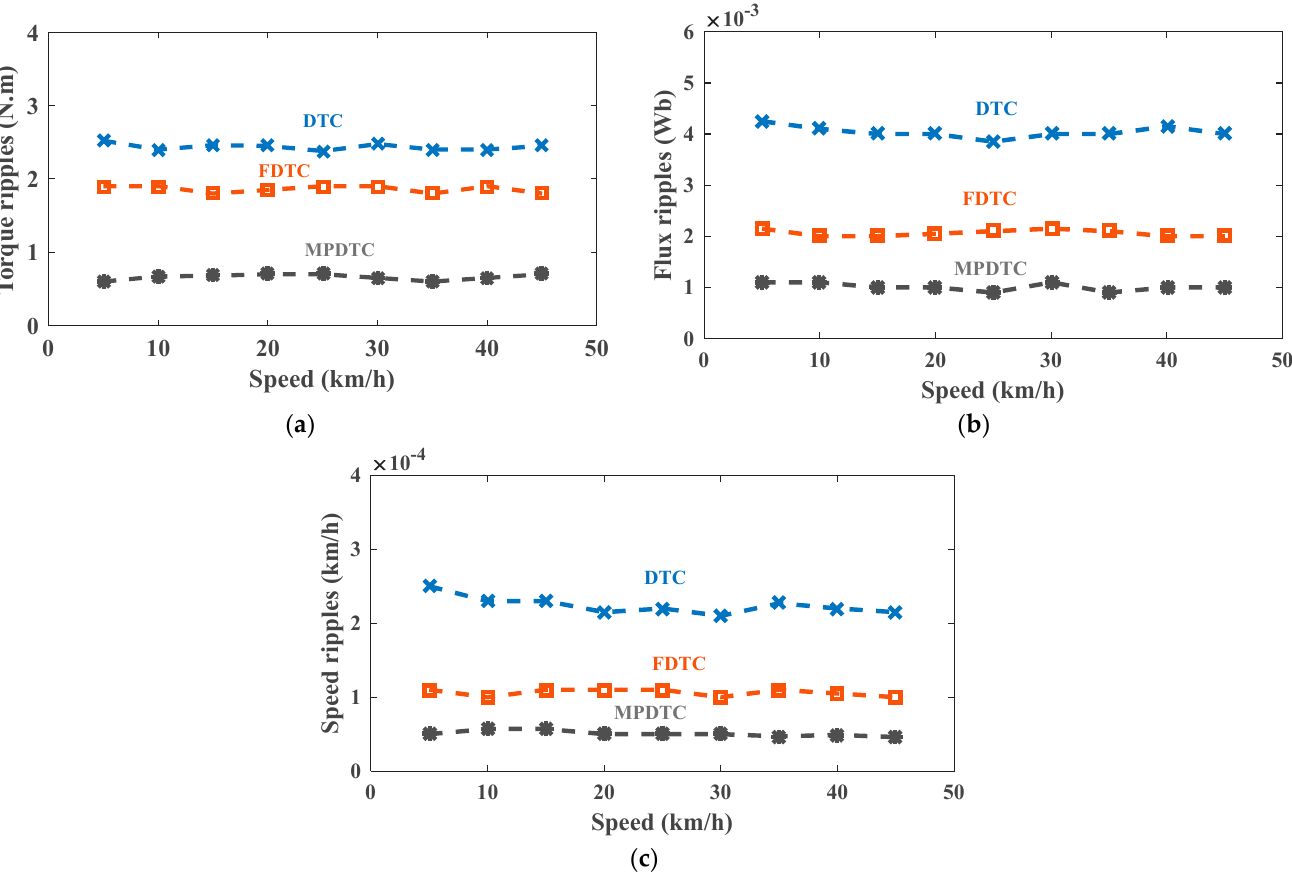
Figure 18. Performance evolution of the di ff erent techniques at various speed values ( a ) Torque ripples; ( b ) Flux ripples; ( c ) Speed ripples.